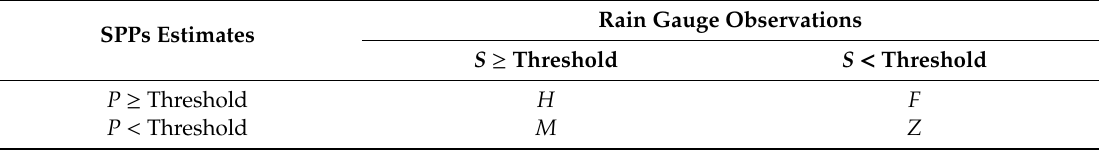
Table 1. Contingency table between rain gauge observations and satellite precipitation